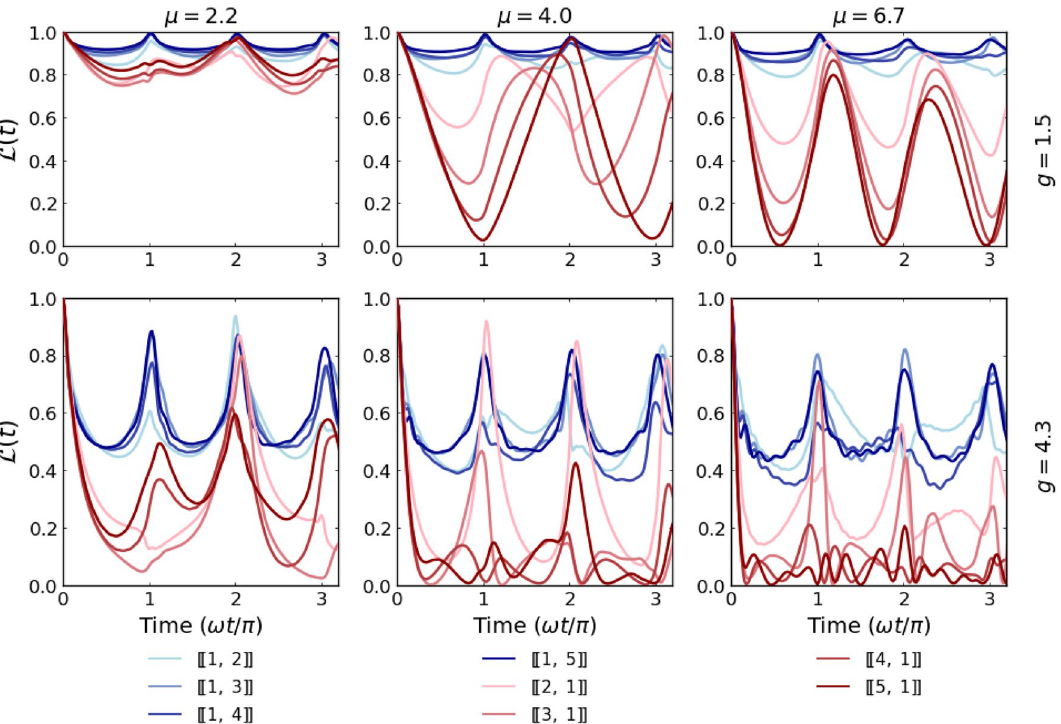
Figure 2. Time evolution of the Loschmidt echo L ( t ) of single-impurity systems containing a different number of particles (blue and red lines respectively for systems interactions (rows) and three different mass ratio (columns). Notice that systems with lighter impurity are much more sensitive than their heavy-impurity